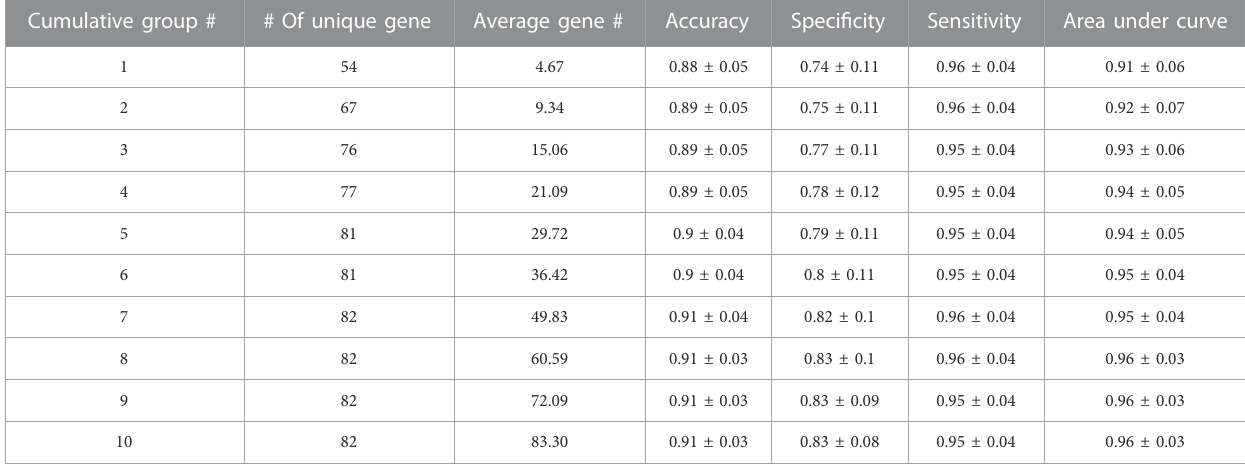
TABLE 1 Performance metrics of 3Mint for the BRCA molecular subtype classi fi cation problem. This output table of 3Mint also presents number of cumulative groups, number of unique genes, average gene number. Cumulative group